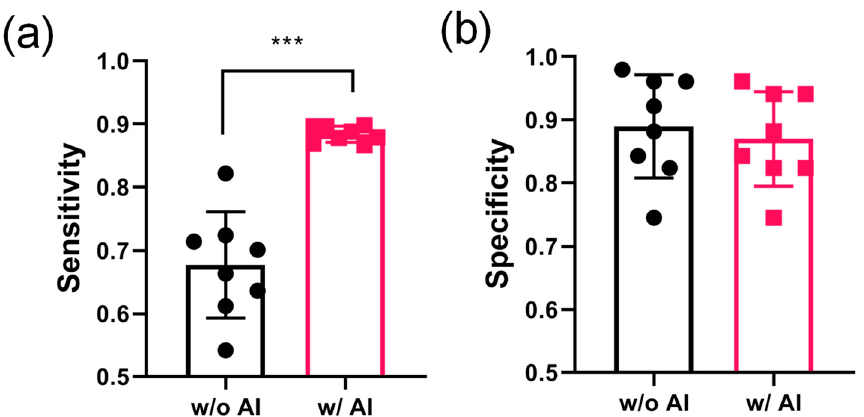
Figure 4. The sensitivity and specificity of lung nodule detection ameliorated by AI-assisted CT screening. The eight junior doctor’s examination results compared with the “Ground Truth” data collected from both medical centers were statistically analyzed. ( a ) Sensitivity; ( b ) specificity. Data represents mean ± SD. *** p < 0.001. AI, artificial intelligence; CT, computed tomography; SD, standard deviation.